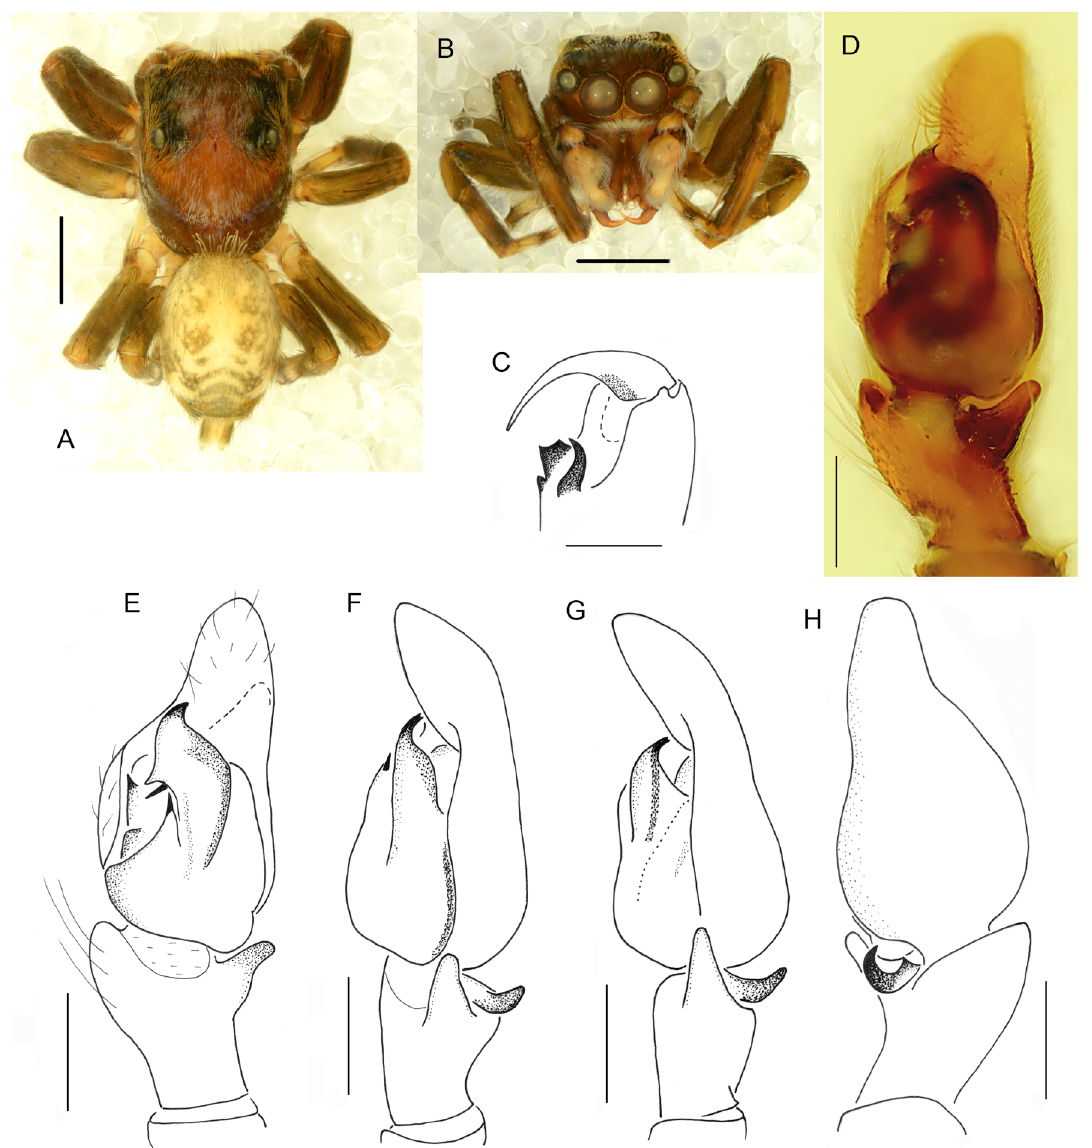
Fig. 11. Pochytoides securis sp. nov., paratypes, ♂. A . General appearance, dorsal view. B . Frontal view. C . Cheliceral dentition. D–H . Palpal organ. D–E . Ventral view. F . Ventroretrolateral view. G . Retrolateral view. H . Dorsal view. scale bars: A–B = 1.0 mm, C–H = 0.3